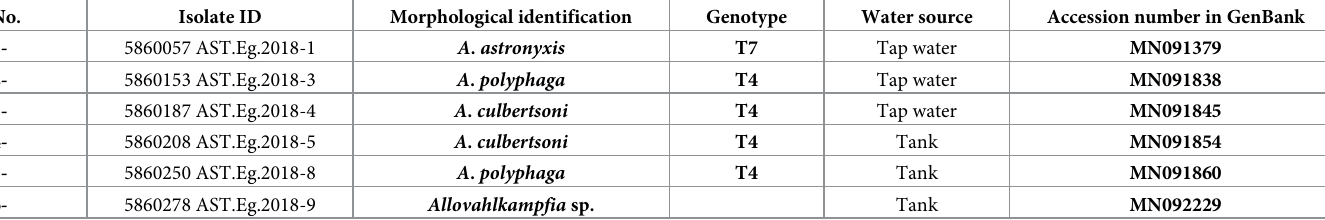
Allovahlkampfia sp. Tank